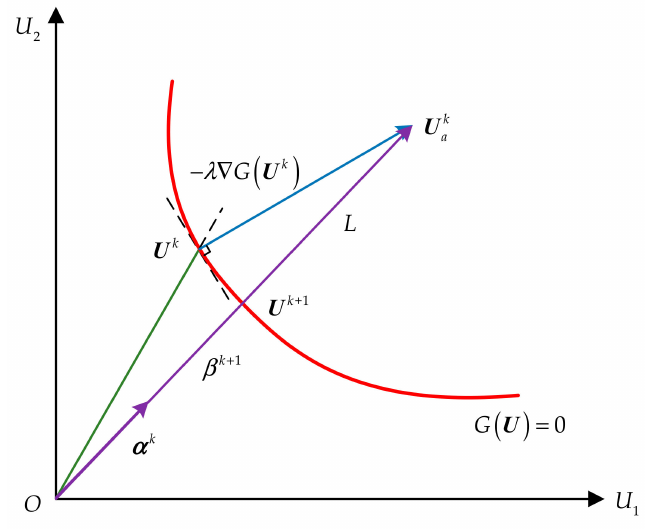
Figure 1. Illustration of the periodic oscillation of the Hasofer–Lind and Rakwitz–Fiessler (HL-RF) algorithm.